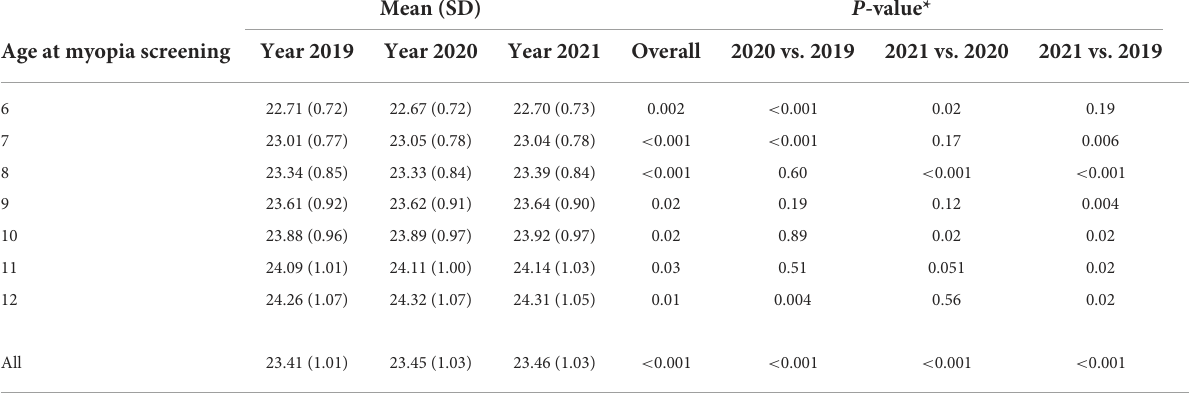
TABLE 3 Comparison of axial length across 3 years overall and stratified by age at myopia screening. Mean (SD) P -value* Age at myopia screening